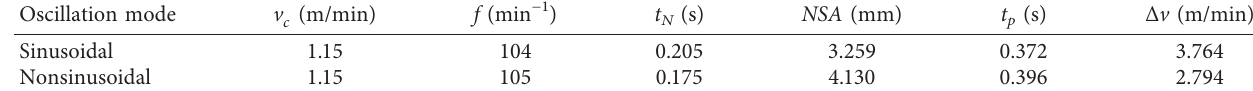
Table 3: Technological parameters of sinusoidal and nonsinusoidal